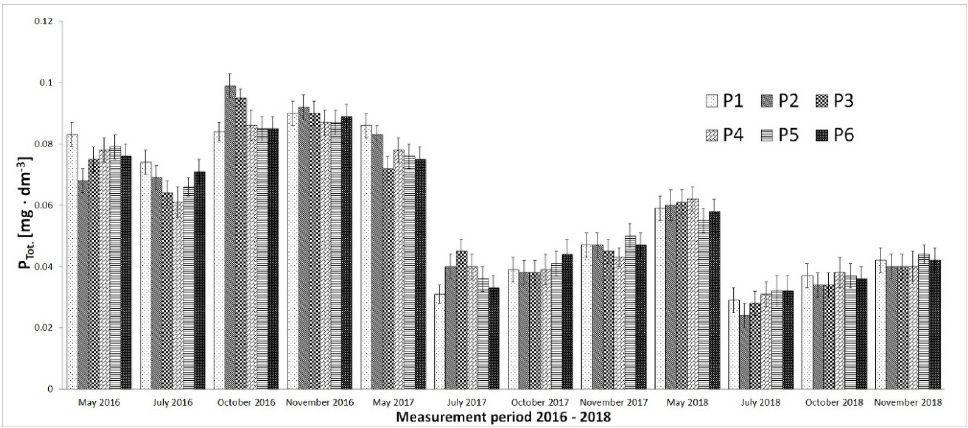
Figure 9. Changes in N tot value at points P1–P6 in the reservoir. Measurement campaigns 2016–2018.